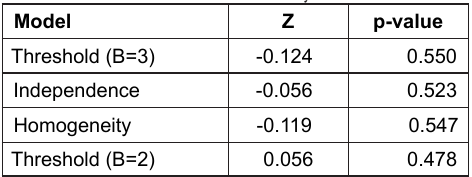
Table 3. Tests for randomness of collar distribution for the Bluenose-East 2000 survey.